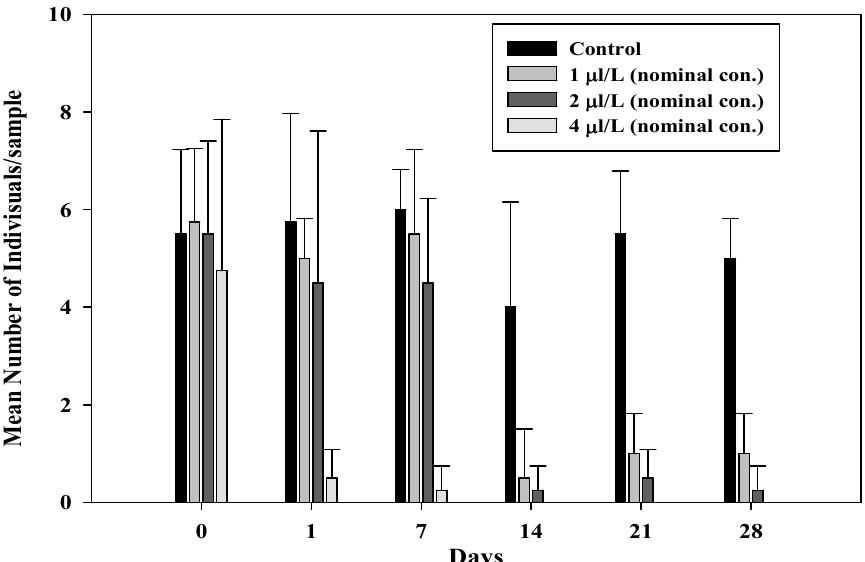
Figure 4. Mean number of G. tokunagai individuals/sample after benzyl chloride exposure.